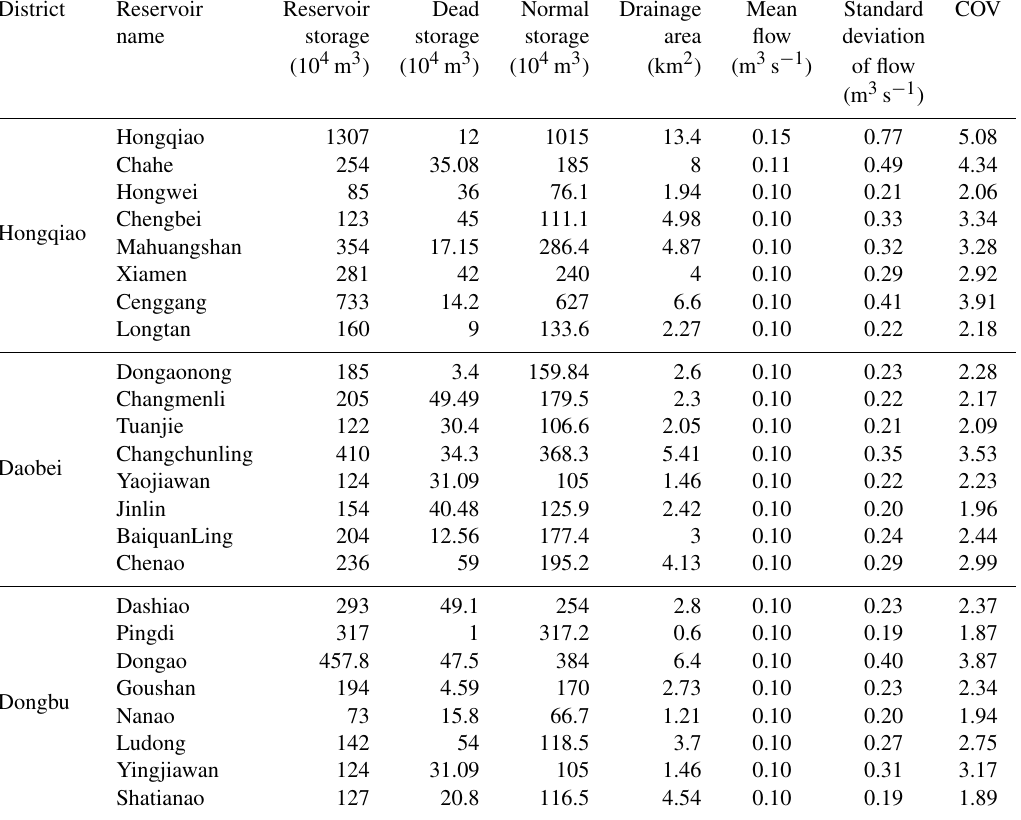
Table 1. Reservoir characteristics in the Zhoushan Islands.